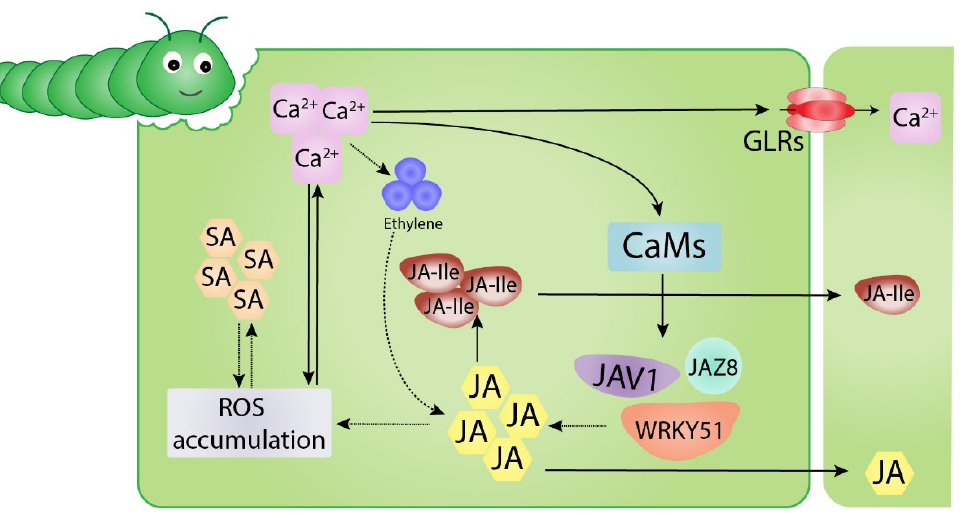
Figure 3. Schematic diagram of the interactions among reactive oxygen species (ROS), Ca 2+ , and phytohormones (JA, jasmonic acid, SA, salicylic acid, and ethylene) within the cell upon biotic attack. Ca 2+ influxes activate ethylene and calmodulins (CaMs) of JAV1, dismantling the JAV1–JAZ8– WRKY51 (JJW) complex to activate JA biosynthesis and thereby producing jasmonoyl-L-isoleucine (JA-Ile). High JA concentrations cause ROS accumulation, which in turn induces SA and vice versa. Distal transfer of Ca 2+ (through glutamate receptor-like (GLR) channels), JA, and JA-Ile occurs between